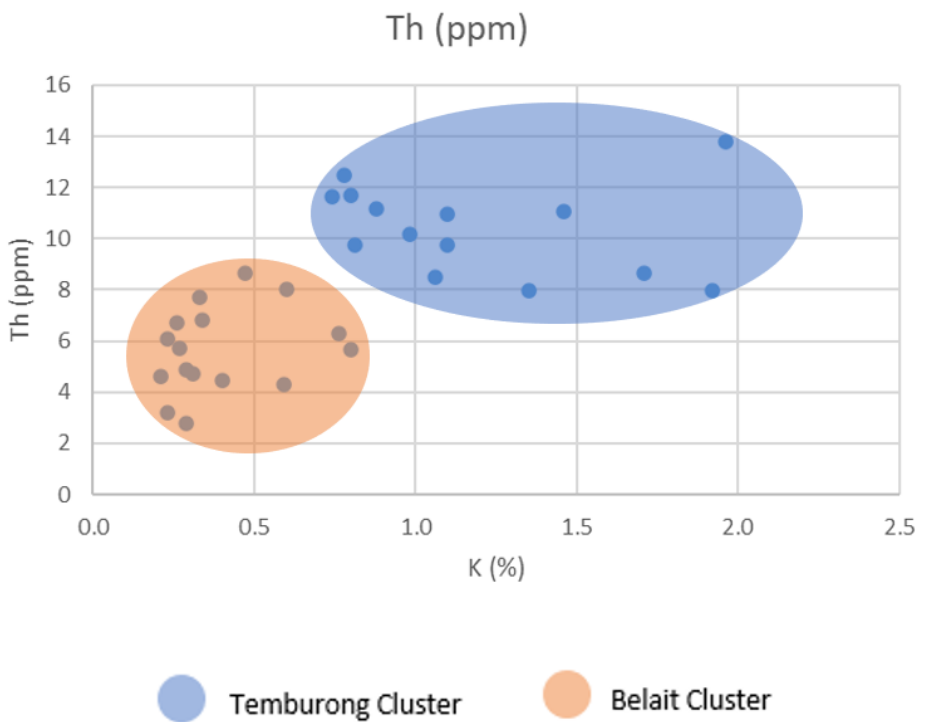
Figure 19. The thorium/potassium cross-plot.